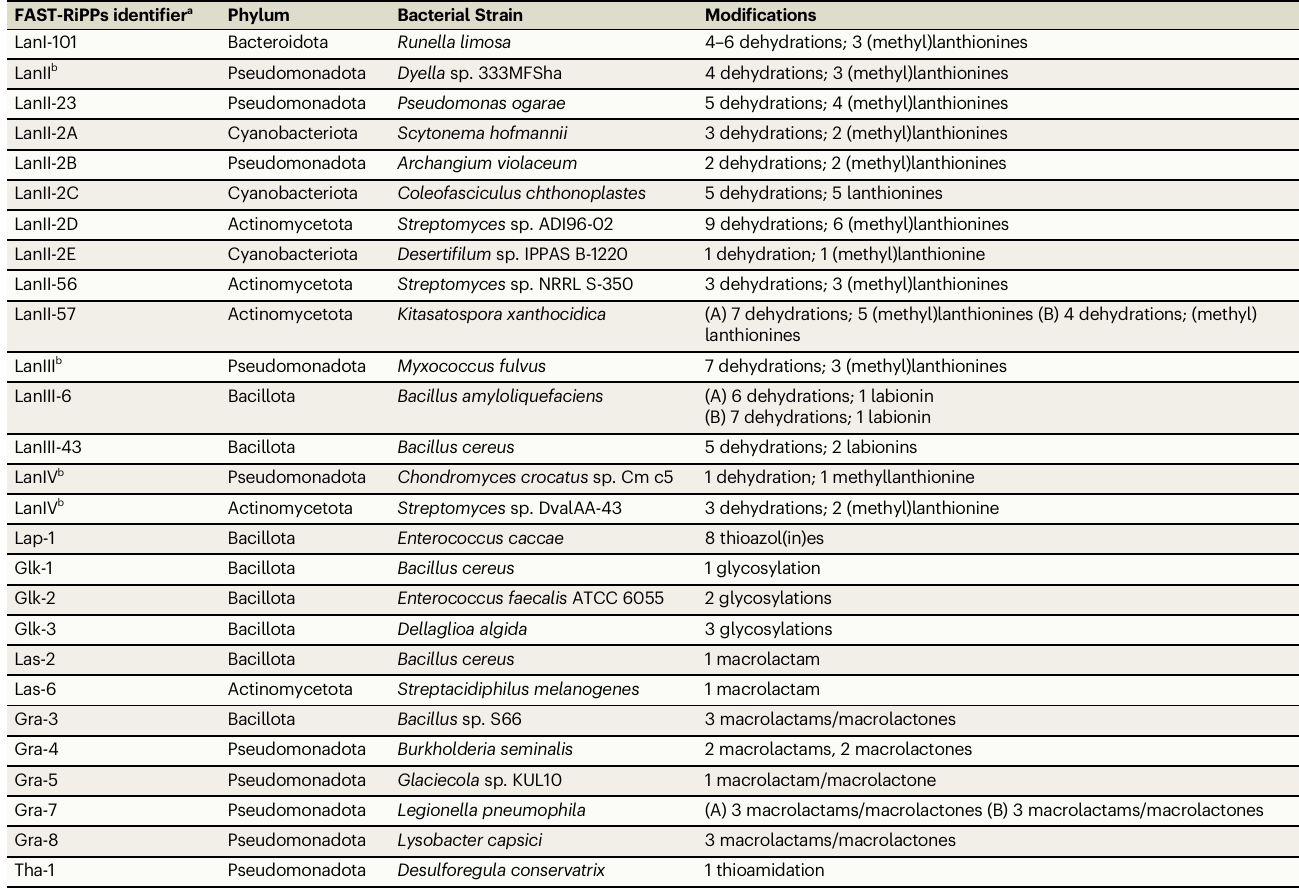
Table 1 | Summary of produced modi fi ed peptides across Bacteroidota, Pseudomonadota, Cyanobacteriota, Actinomycetota and Bacillota